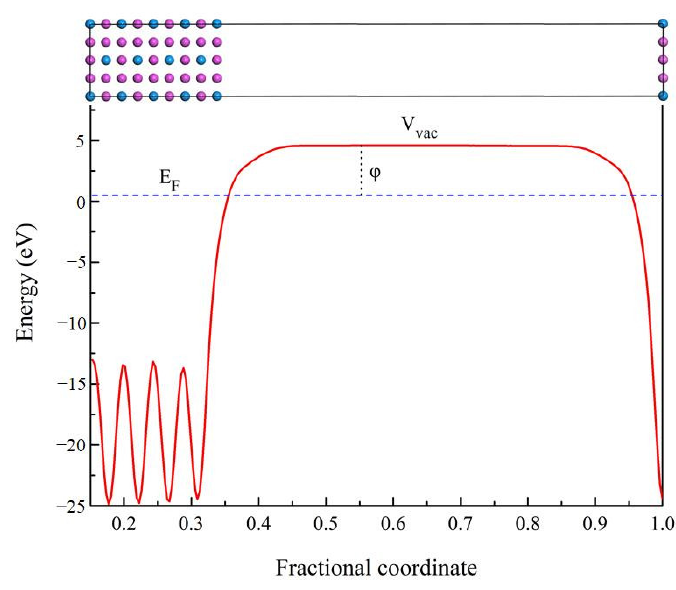
Figure 11. The schematic diagram of the electronic movement related to work function.